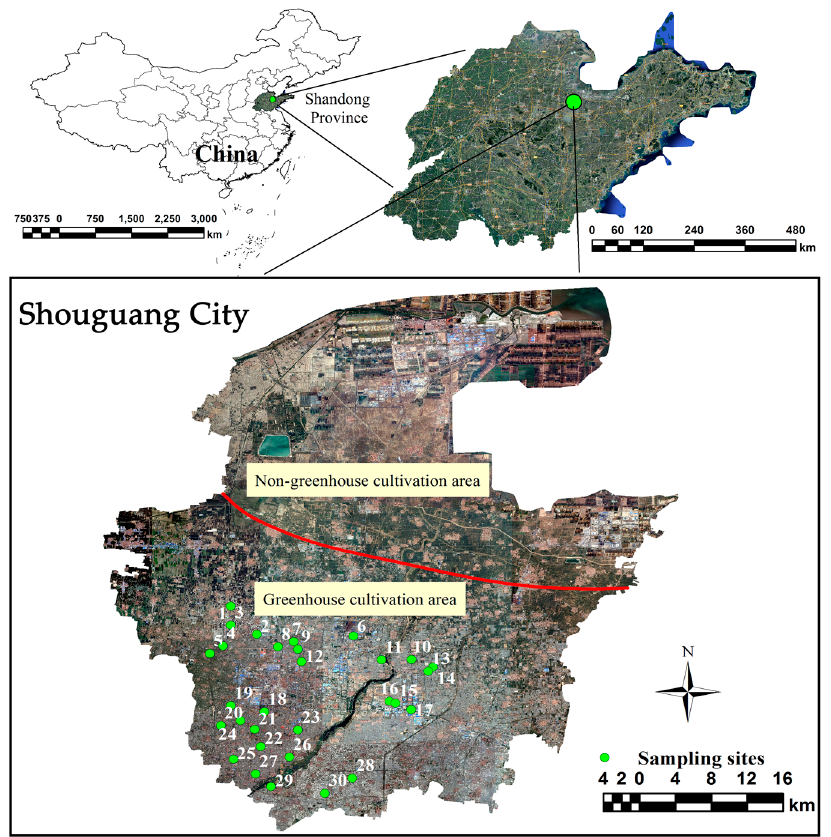
Figure 1. The distribution of sampling sites in the study region (denoted by green circles).